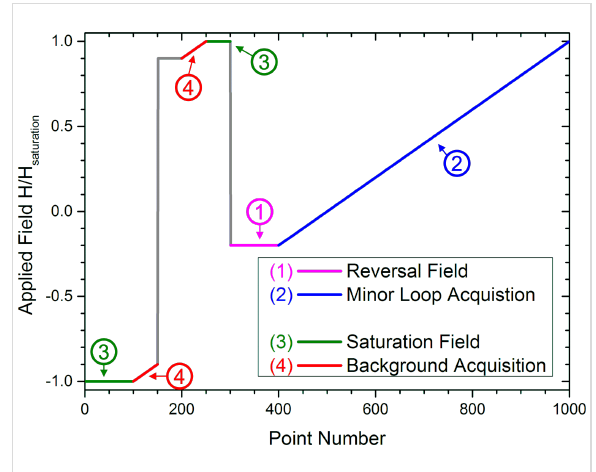
Figure 4: Field profile adapted to minor loop measurements with MOKE. Part 3 and 4 (green and red) are used for signal referencing. Part 1 (pink) is the variable reversal field and part 2 (blue) is related to the measurement of the minor loop itself. Reproduced with permission from [23], copyright 2014 AIP Publishing